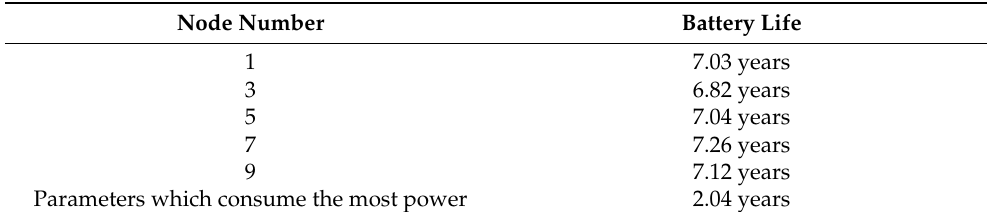
Table 9. Battery life of sensor